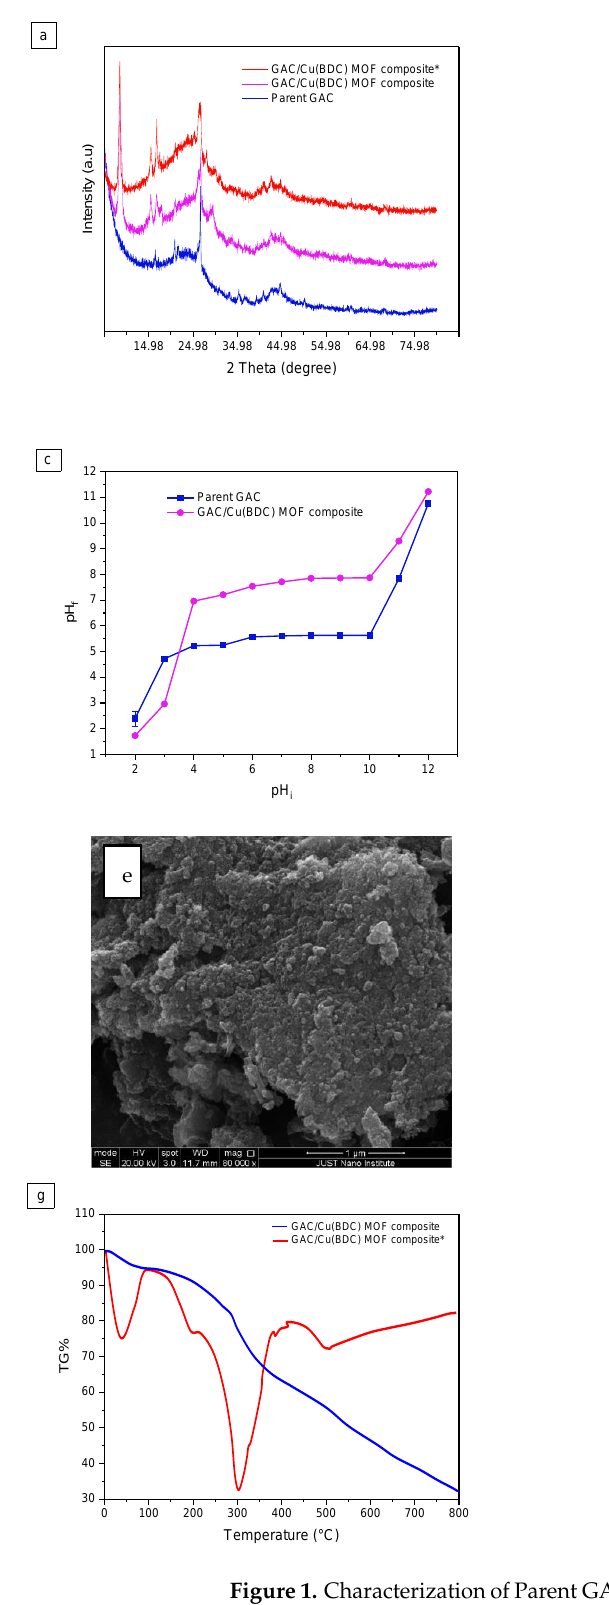
Figure 1. Characterization of Parent GAC, GAC/Cu(BDC) MOF composite, and GAC/Cu(BDC) MOF composite* by ( a ) XRD, ( b ) FTIR, ( c ) the point of zero charges (pHpzc), ( d ) N 2 adsorption-desorption isotherms at 77.4 K, ( e ) SEM images (parent GAC), ( f ) SEM images (GAC/Cu(BDC) MOF composite), and ( g )